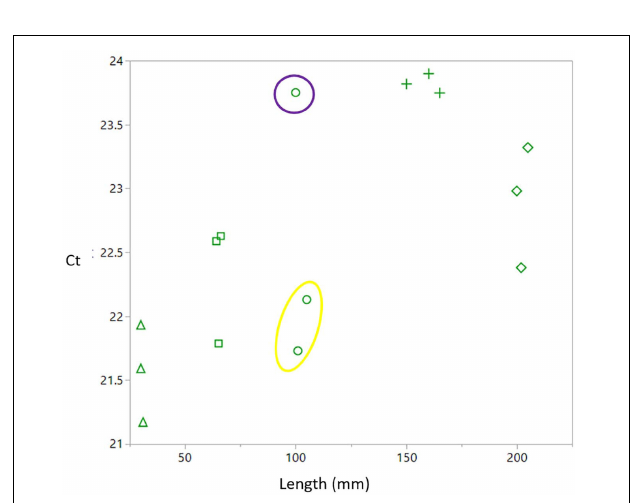
All pups were plotted in a linear regression comparing total length of Ct value. A significant relationship ( R 2 = 0.43, p = 0.008) was found within the pups, as was found with all individuals